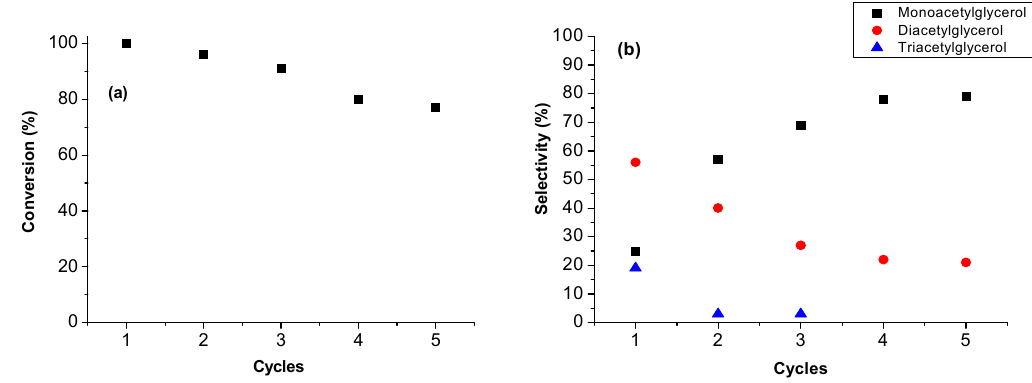
Figure 9. Recycling runs during 1 h of the glycerol acetylation over Zr 4 (PO 4 ) 2 (SO 4 ) 5 . Both glycerol conversion ( a ) and selectivity ( b ) towards the acetins are shown.